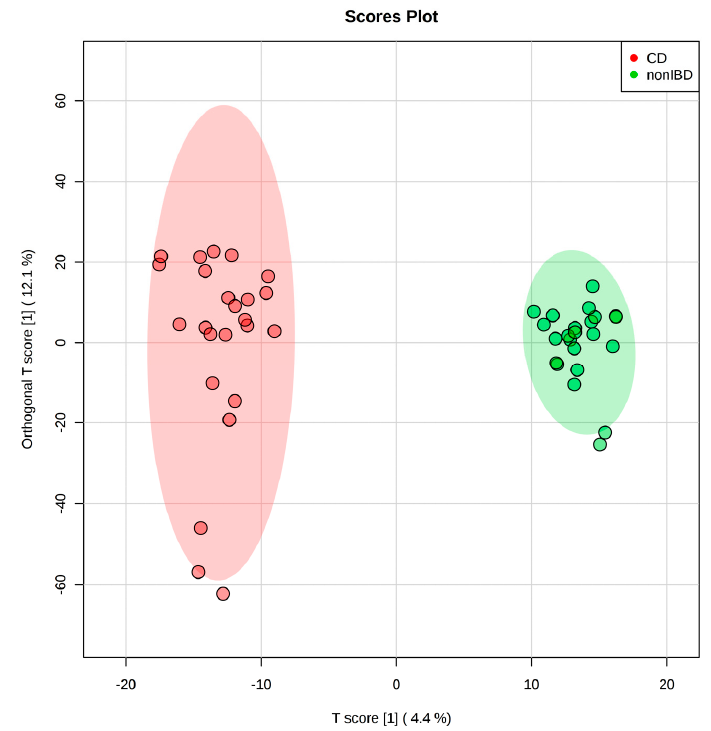
Figure 2. The OPLS-DA score plot based on the stool metabolome of 24 pediatric Crohn’s disease patients and 24 healthy children